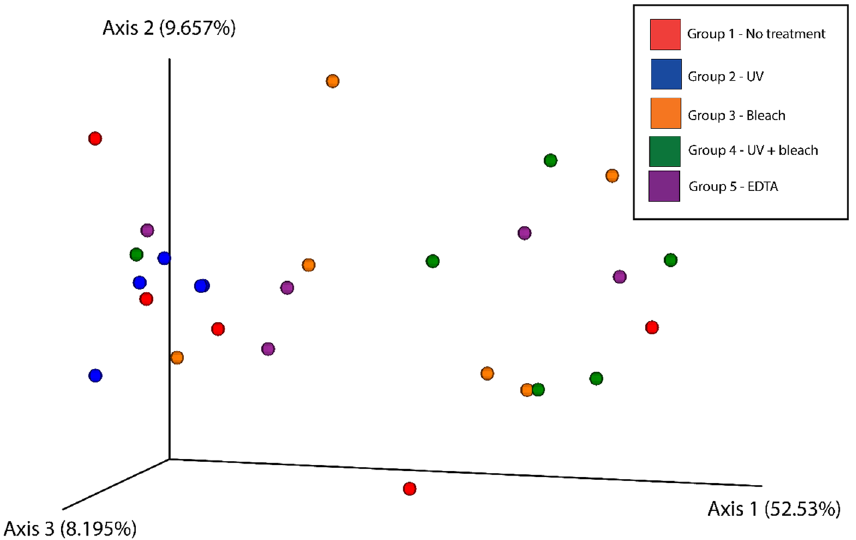
Figure 6. Principal Coordinates Analysis (PCoA) plot based on Bray–Curtis dissimilarity for the shotgun dataset. Points in three-dimensional space represent samples, each colored according to treatment. Statistical analysis revealed a non-significant separation between samples based on treatment (Kruskal–Wallis, p value > 0.05). Plot generated using the EMPEROR tool in QIIME2 48